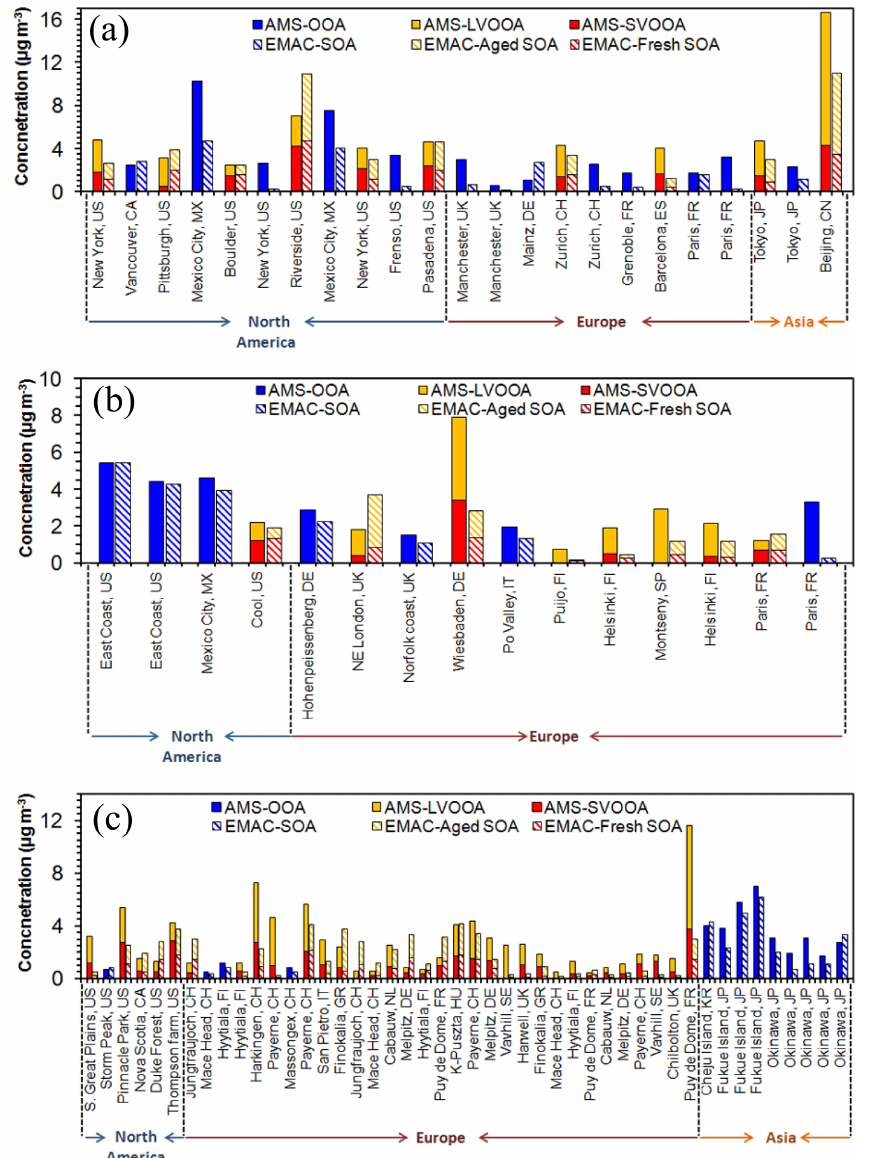
Figure 12. Comparison of EMAC SOA (fresh SOA and aged SOA) to AMS OOA (SV-OOA and LV-OOA) from 84 data sets worldwide over (a) urban, (b) urban downwind, and (c) rural/remote areas during